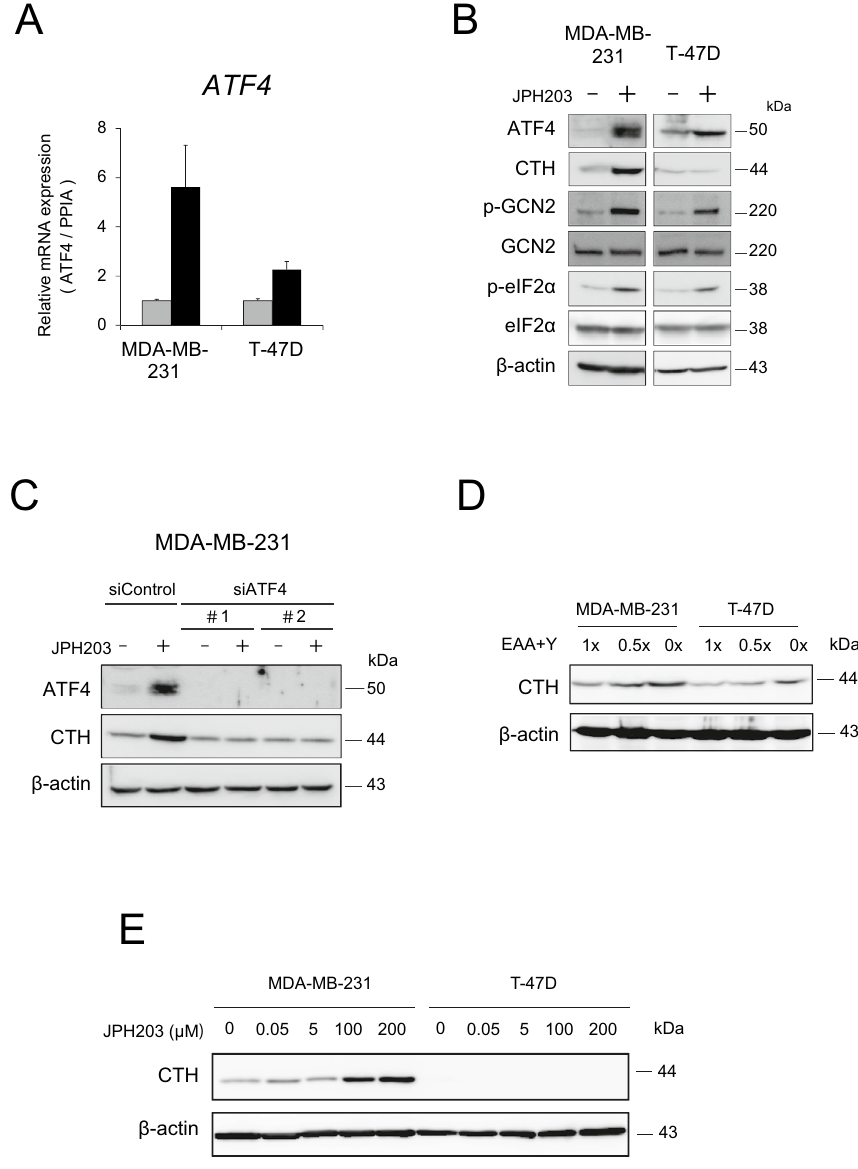
Figure 3. Activation of amino acid starvation stress pathway in cells in response to JPH203 or LAT1 substrate amino acids restriction. ( A ) ATF4 mRNA expression in the presence/absence of 100 μM JPH203 for 12 h in MDA-MB-231 and T-47D cells by qPCR. ( B ) MDA-MB-231 and T-47D cells were incubated for 12 h in the absence or presence of 100 μM (MDA-MB-231) and 5 μM (T-47D) of JPH203. The cell lysates were subjected to western blot analysis for ATF4, CTH, phospho-GCN2, phospho-eIF2α. ( C ) MDA-MB-231 cells were transfected with control (scrambled) or ATF4 siRNA. These transfected cells were incubated in the presence/absence of 100 μM of JPH203 for 12 h. The cell lysates were subjected to western blot and probed for CTH and β-actin (loading control). ( D ) After MDA-MB-231 and T-47D cells were incubated for 72 h in amino acid restriction media, the cell lysates were subjected to western blot analysis and probed for CTH and β-actin (loading control). LAT1 substrate amino acids, which are eight essential amino acids (EAA; l-isoleucine, l-phenylalanine, l-tryptophan, l-valine, l-histidine, l-leucine and l-methionine) and l-tyrosine, were removed from normal RPMI (1.0) to 50% (0.5), or free (0). ( E ) MDA-MB-231 and T-47D cells were treated with JPH203 at different concentrations (0, 0.05, 5, 100 or 200 µM) for 48 h. The cell lysates were subjected to western blot analysis for determining CTH protein